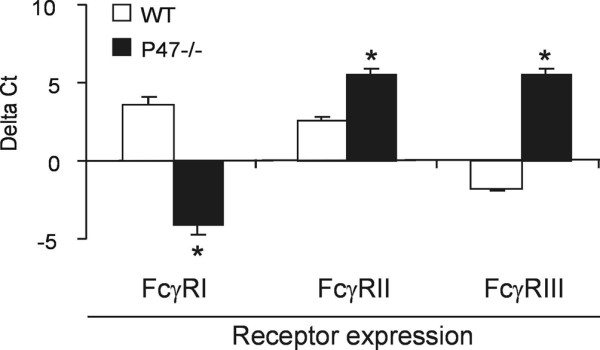
mRNA levels of various FcγRs in synovia derived from inflamed knee joints. Inflamed synovia were isolated 7 days after IFN-γ-stimulated arthritis. The cycle threshold value (Ct) of the various FcγR genes was corrected for glyceraldehyde-3-phosphate dehydrogenase content and for values at zero time. Note that at day 7 significantly lower levels of FcγRI and elevated levels of FcγRII and FcγRIII were found in p47phox-/- mice than in controls.